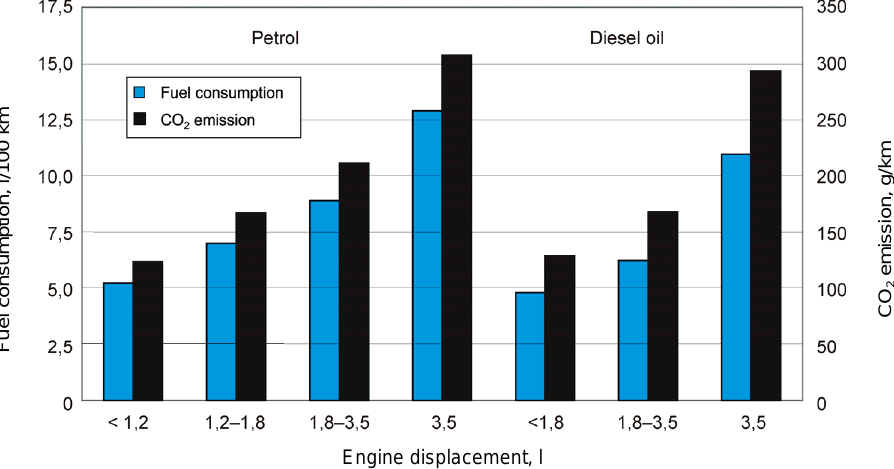
Fig 3. Average fuel consumption and CO 2 emission by a motor car depending on its engine